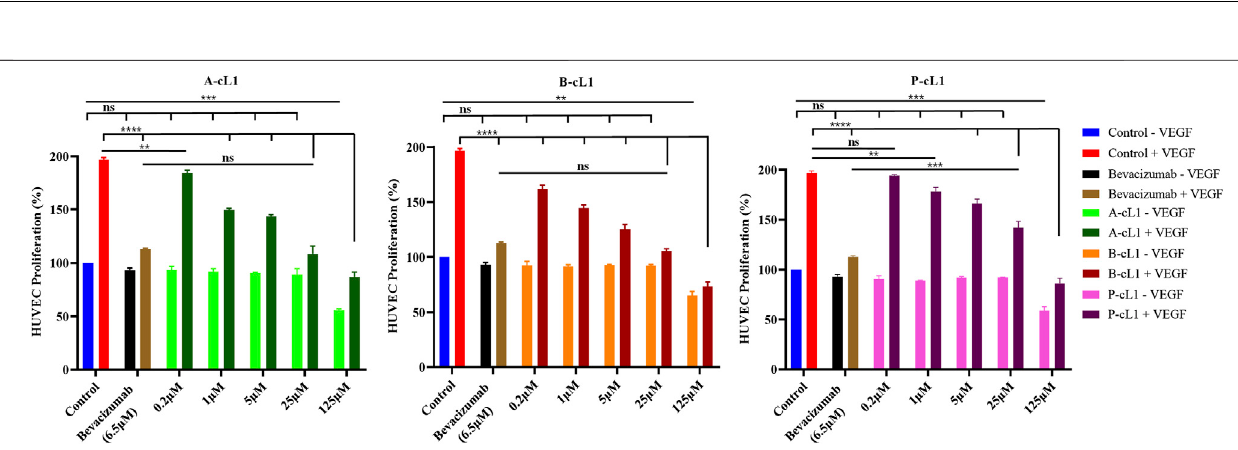
FIGURE2| DockingmodelofpeptidesA-cL1,B-cL1,andP-cL1withVEGFR1D2-D3.BindingresiduesonVEGFR1D2-D3areinpurple;hydrogenbondslabelled in green dash lines; hydrophobic effects labelled in violet dash lines. (A) Binding between A-cL1 (green) and VEGFR1 D2-D3 (turquoise), (B) Binding between B-cL1 (orange) and VEGFR1 D2-D3 (turquoise); (C) Binding between P-cL1 (pink) and VEGFR1 D2-D3 (turquoise).